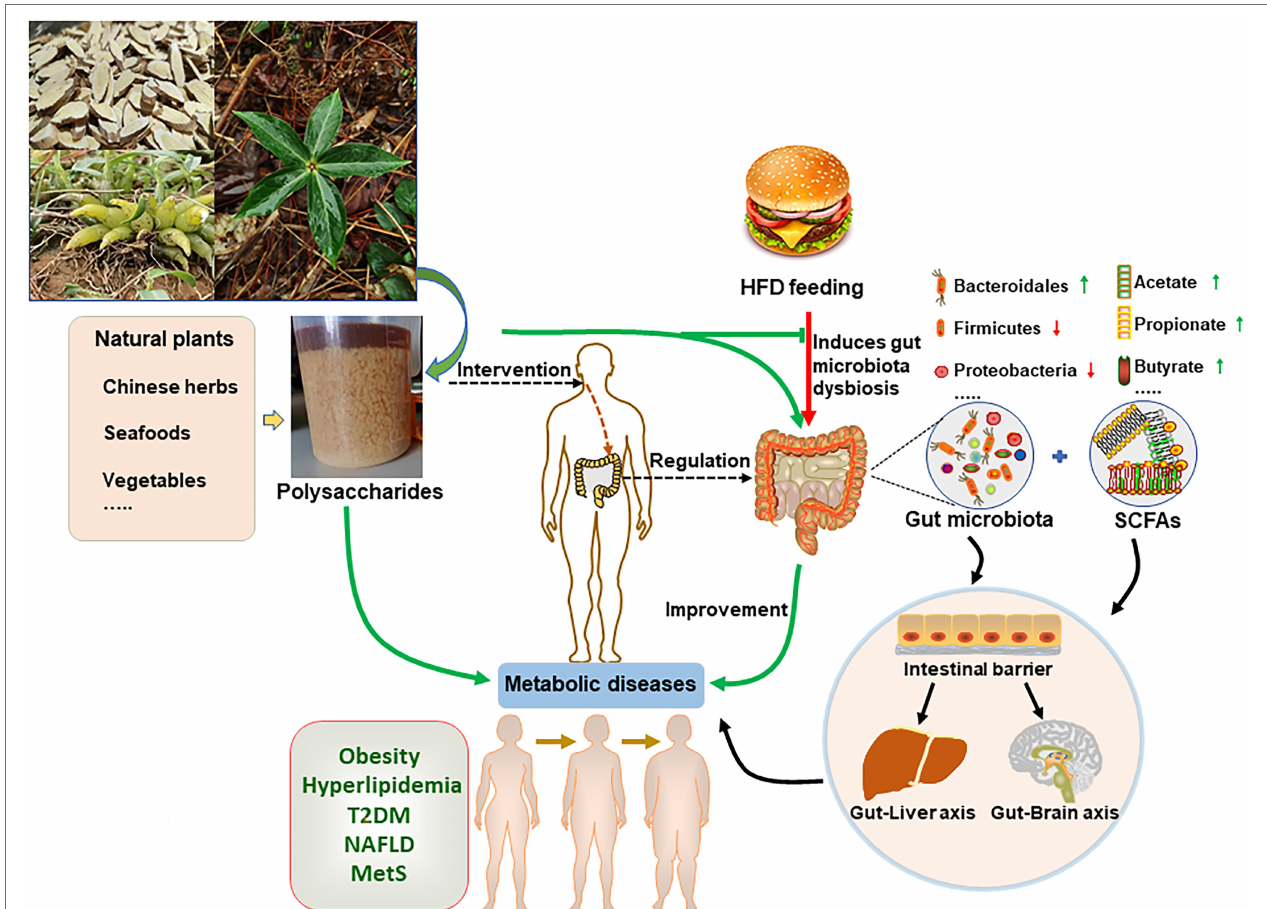
FIGURE 1 | Natural polysaccharides improve high-fat diet (HFD)-induced metabolic diseases through regulating gut microbiota. Plants or animals-derived polysaccharides are fermented by gut microorganism, and produce metabolites, such as short-chain fatty acids (SCFAs). In turn, these metabolites regulate the intestinal microbiota composition. HFD induce gut microbiota dysbiosis that contributes to obesity-associated chronic metabolic diseases. In this regard, natural polysaccharides reverse HFD-induced metabolic diseases by regulating gut